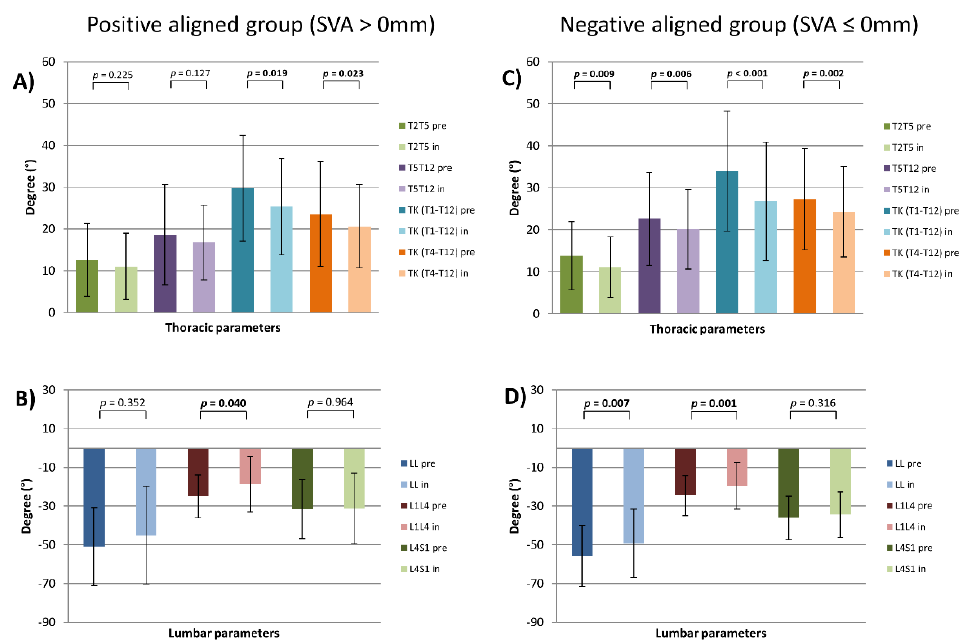
Figure 8. Thoracic and lumbar parameters by sagittal vertical axis (SVA) stratified patients (pre- and in-brace). ( A ) thoracic and ( B ) lumbar parameters of the positive aligned group. ( C ) thoracic and ( D ) lumbar parameters of the negative aligned group; p = statistical significance, p < 0.05.